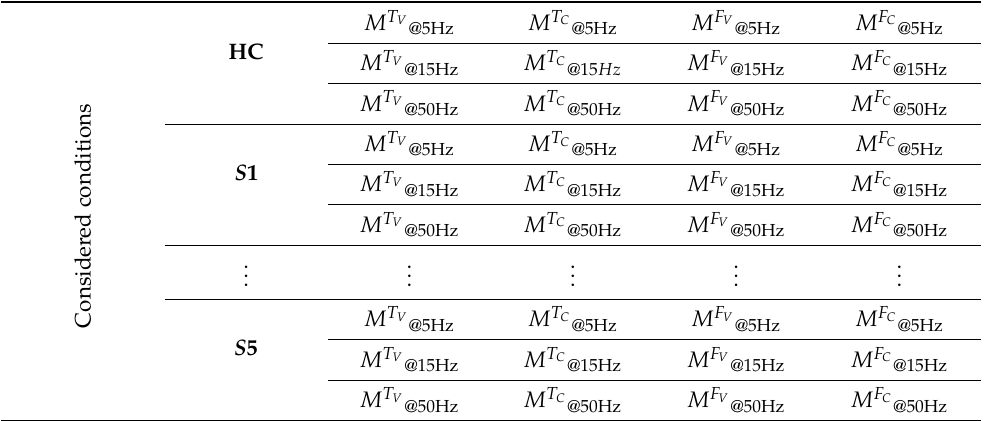
Table 3. The arrangement of feature matrices that are subjected to the feature extraction and fusion domain